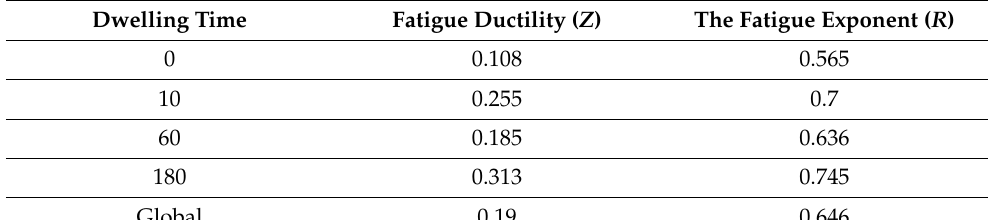
Figure 28. Characteristic life vs. plastic strain for SAC305 joints at various dwelling times on a log– log scale.